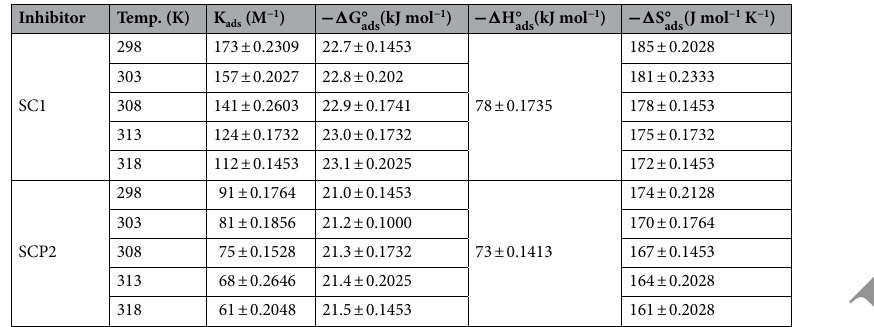
Table 7. Shows the kinetic characteristics of the studied chemicals as a function of temperature for C-steel dissolving at 0.5 M H 2 SO 4 in SC1 and SCP2.